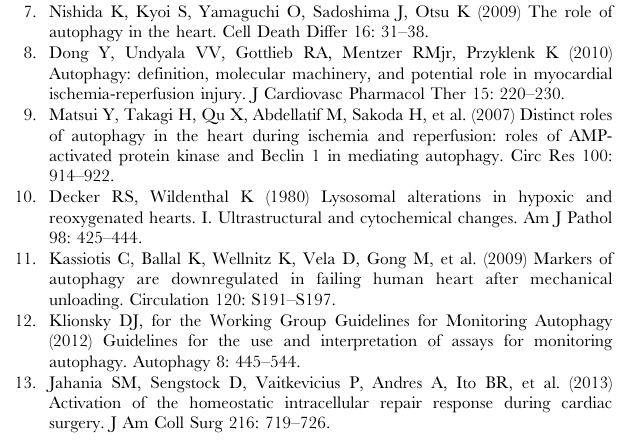
Figure S1 Original Ponceau stainings with the respec- tive glyceraldehyde 3-phosphate dehydrogenase (GAPDH) immunreactivities. Western blots were used to detect expression of autophagy-related gene 5-12 complex (ATG5- 12) (immunreactivities in Figure 2) and parkin (immunreactivities in Figure 5) in myocardial biopsies obtained at baseline (BL) before (R10) from patients undergoing remote ischemic preconditioning